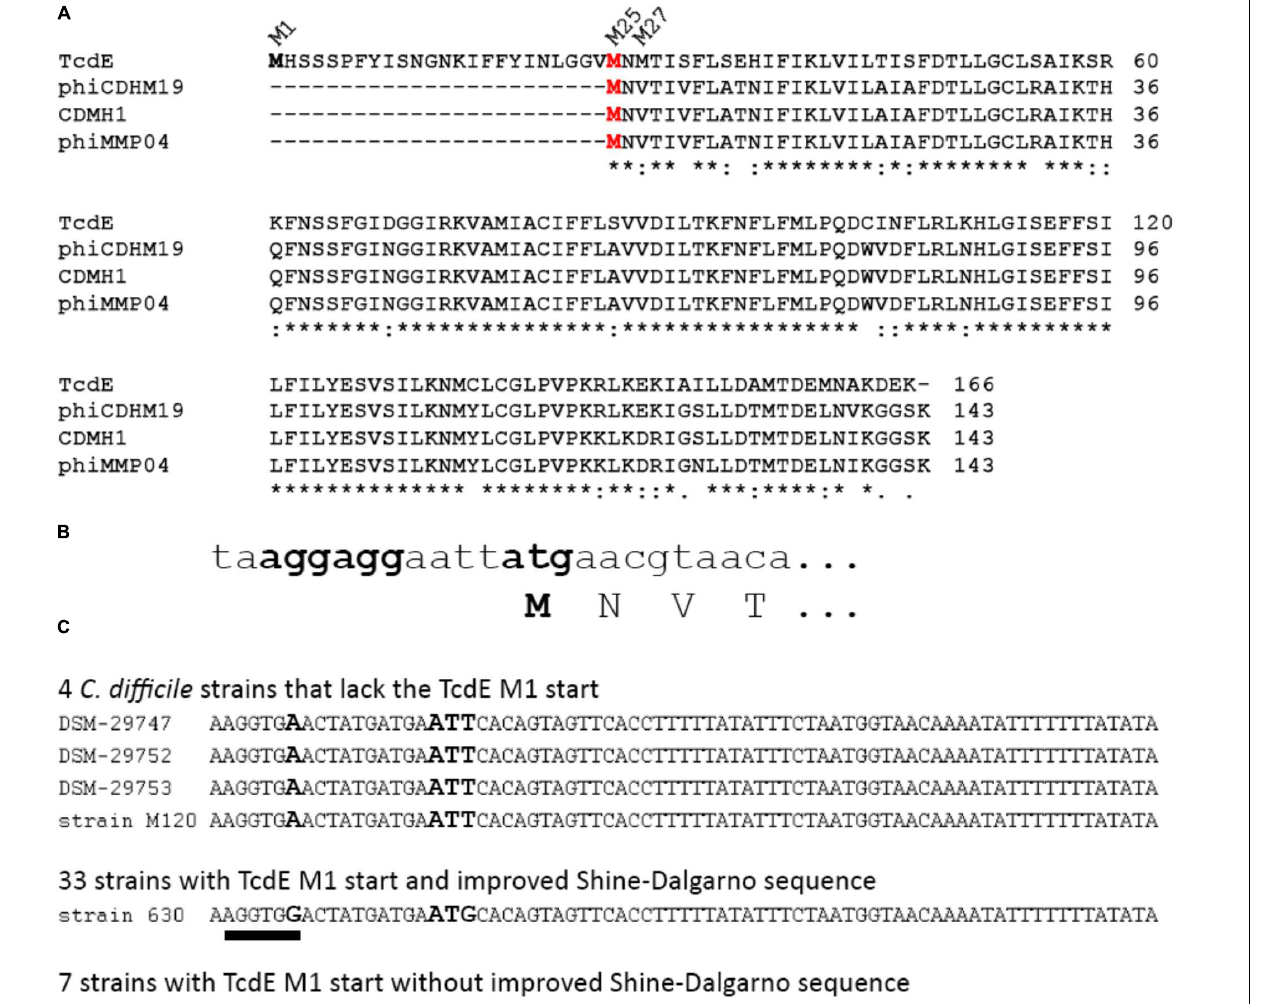
initiation at M1 evolved in C. difficile , and not in phages,